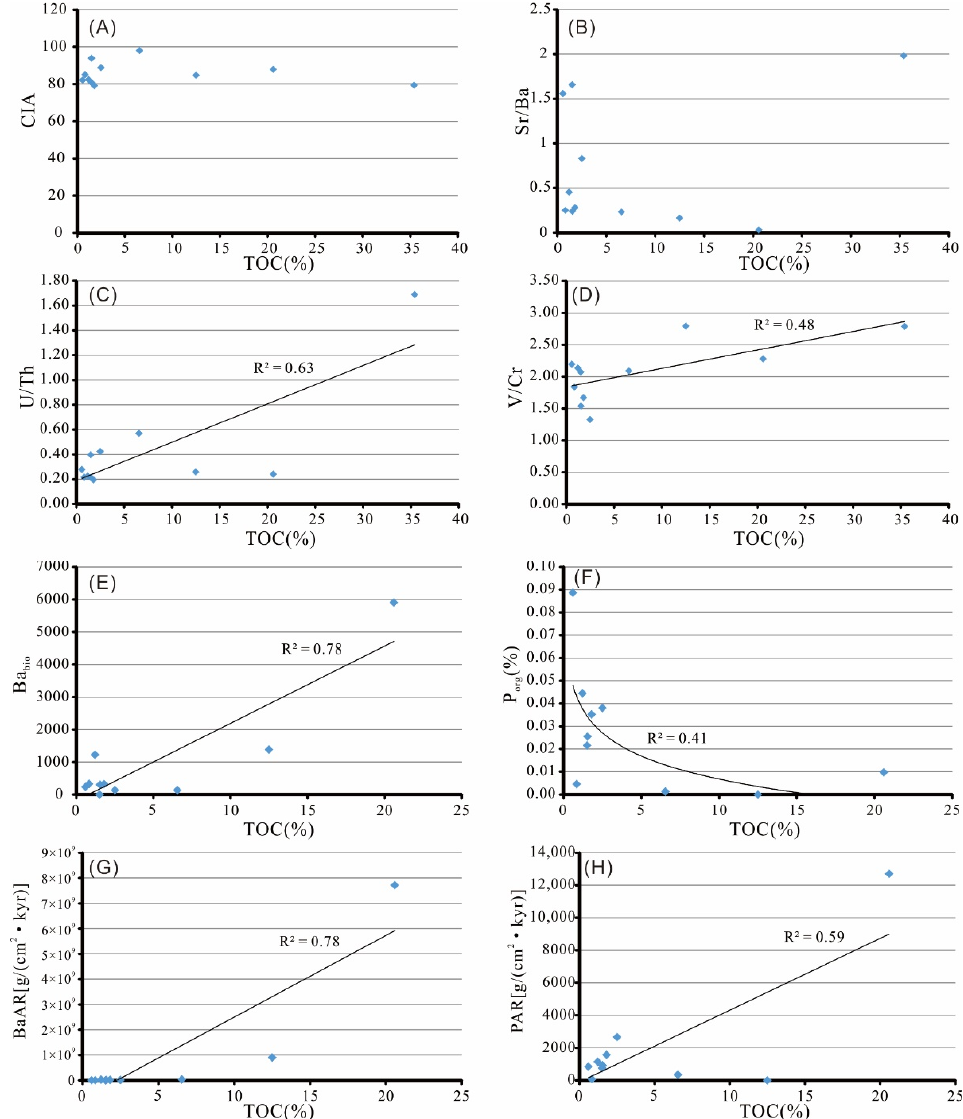
Figure 7. Correlation of TOC with paleoclimate, paleo-water salinity, paleoproductivity, and paleo-redox proxies: ( A ) Correlations between TOC and CIA; ( B ) Correlations between TOC and Sr/Ba; ( C ) Correlations between TOC and U/Th; ( D ) Correlations between TOC and V/Cr; ( E ) Correlations between TOC and Ba bio ; ( F ) Correlations between TOC and P org ; ( G ) Correlations between TOC and BaAR; ( H ) Correlations between TOC and PAR.